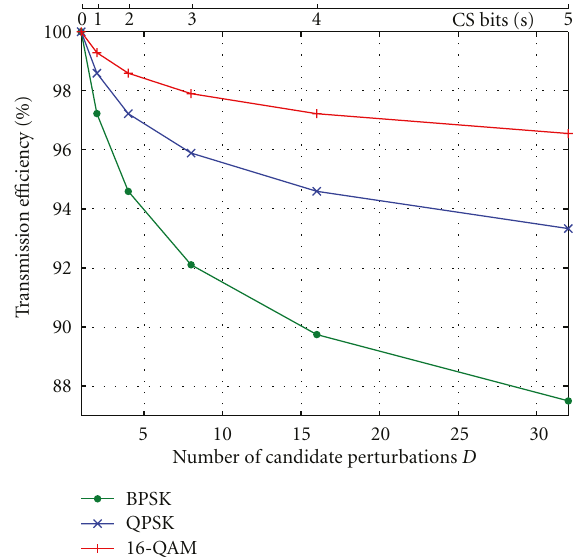
Figure 7: Transmission-reception e ffi ciency for SA for increasing D , N = M = 5, N t = 7, QPSK.